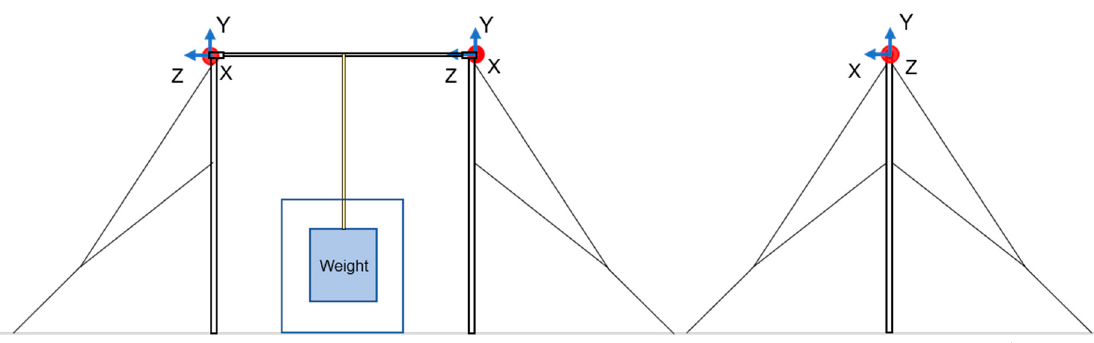
Figure 1. Experimental